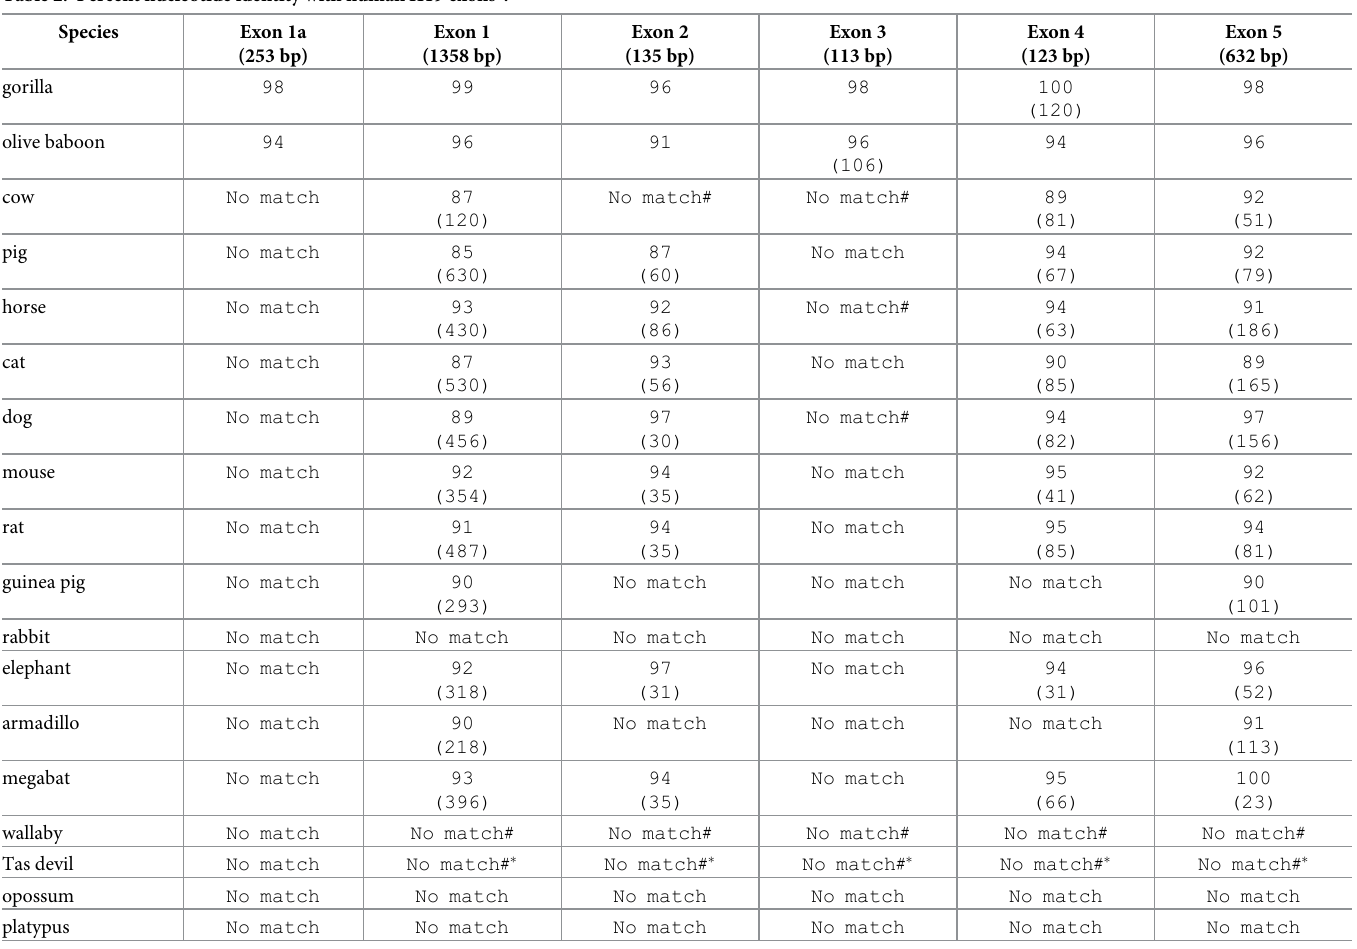
Table 2. Percent nucleotide identity with human H19 exons ¶ . Species